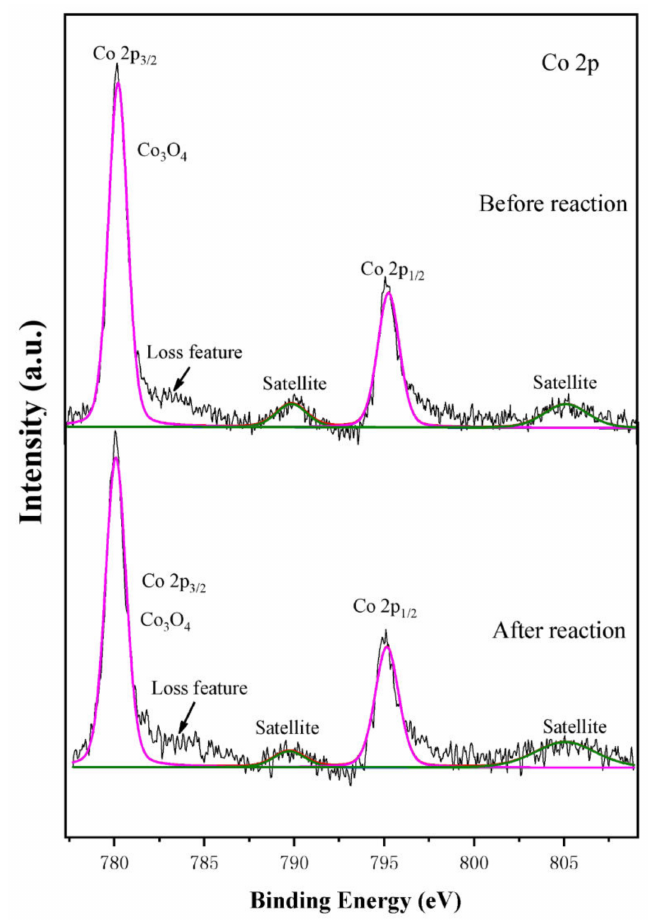
Figure 8. XPS of Co2p over the Co 0.3